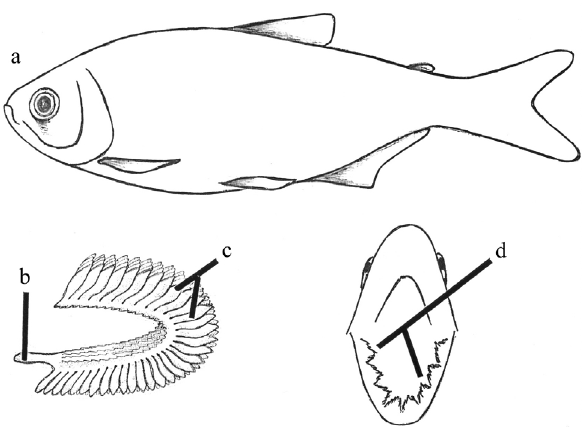
Figure 2 - Some morphological characteristics of Astyanax : a = gill; b = inferior jaw teeth; c = pectoral and pelvic fin